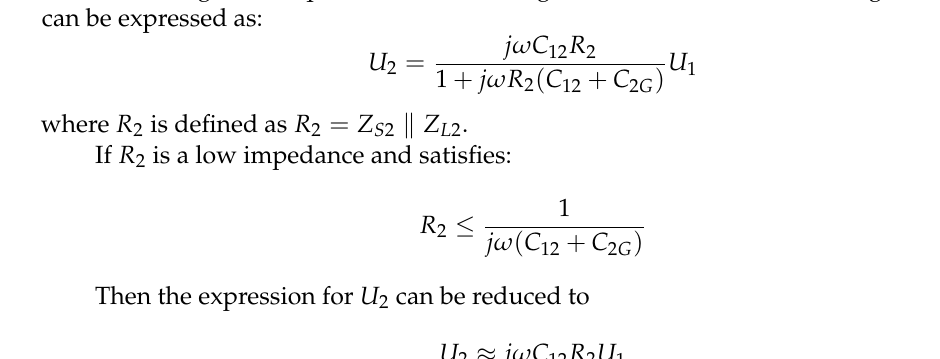
where R 2 is defined as R 2 = Z S 2 (cid:107) Z L 2 .